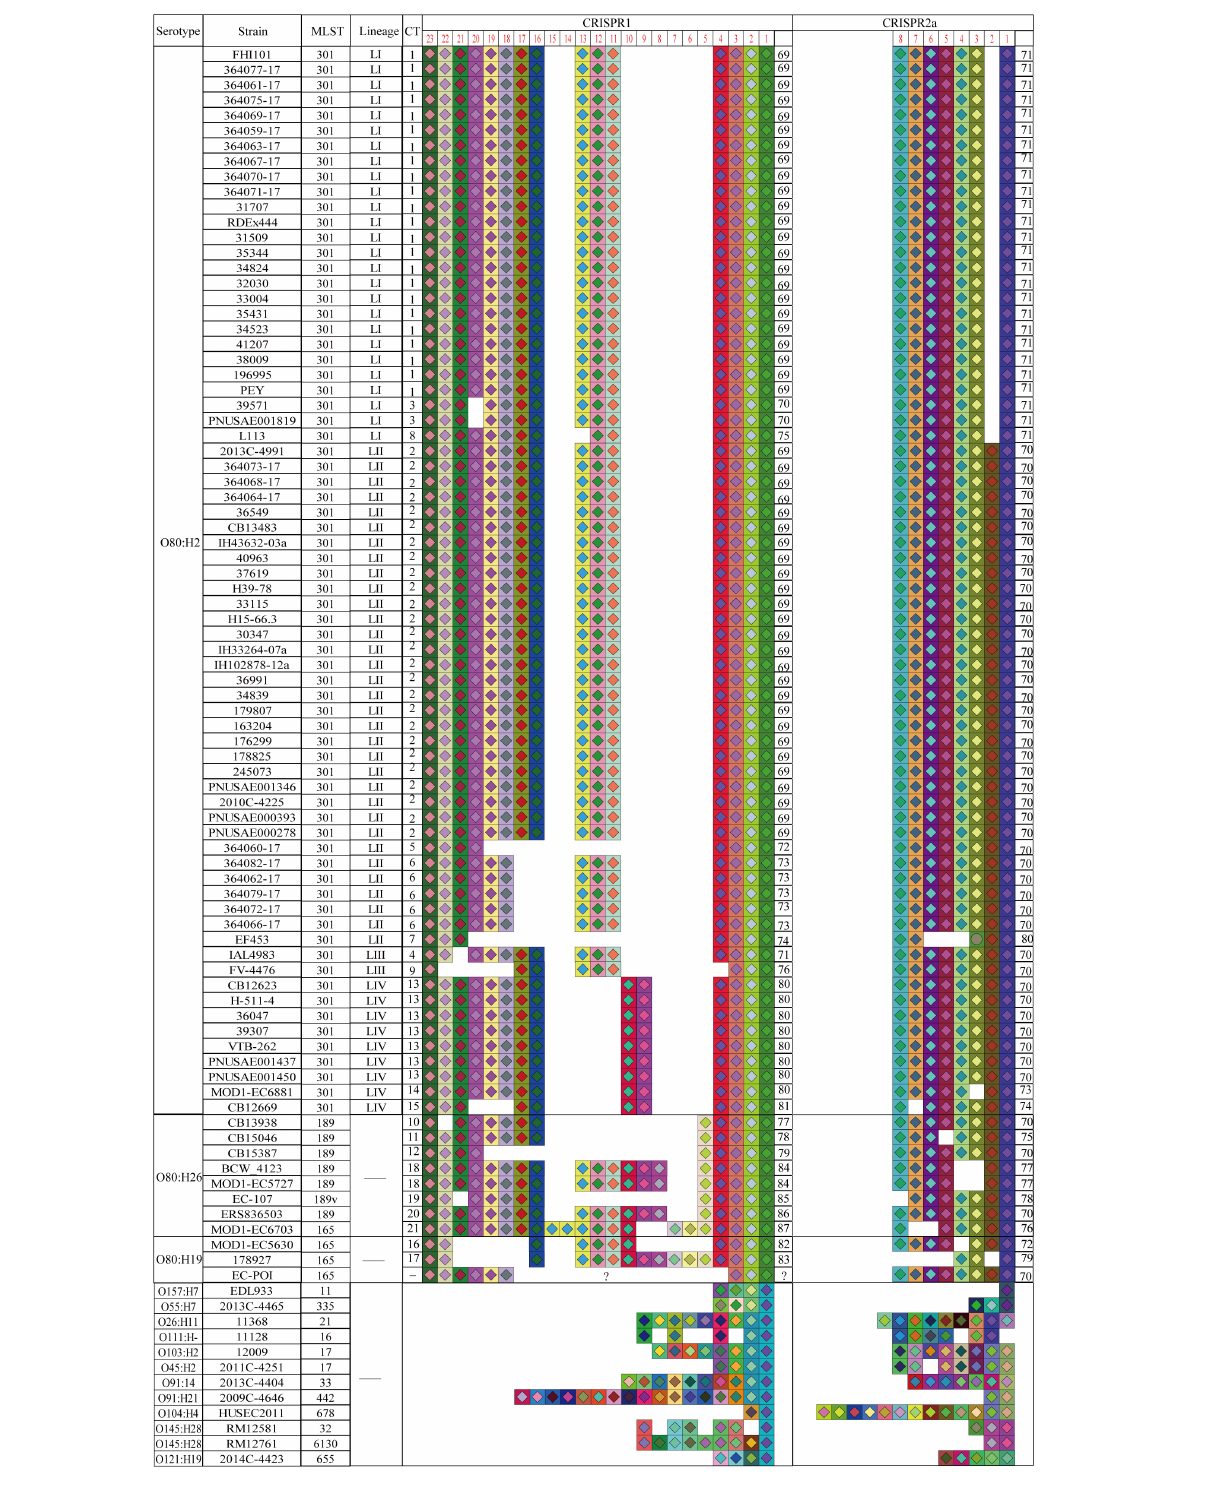
FIGURE 2 | Spacer organizations and arrangements of STEC O80 strains as well as 12 reference STEC strains. Spacer is represented by one square, and each unique spacer sequence is marked as the combination of a unique color and one center symbol. The symbol in the center indicates the length of spacer (diamond for 32 bp and circle for 31 bp). Spacer numbering is initiated at the ancestral end (right) toward the most recently acquired spacers (left) per strain. The left side represents CRISPR1, and the right represents CRISPR2 for the same strain in the same line. The serotype, MLST, CRISPR lineage, CRISPR type, CRISPR1 allele, and CRISPR2 allele are displayed in the corresponding